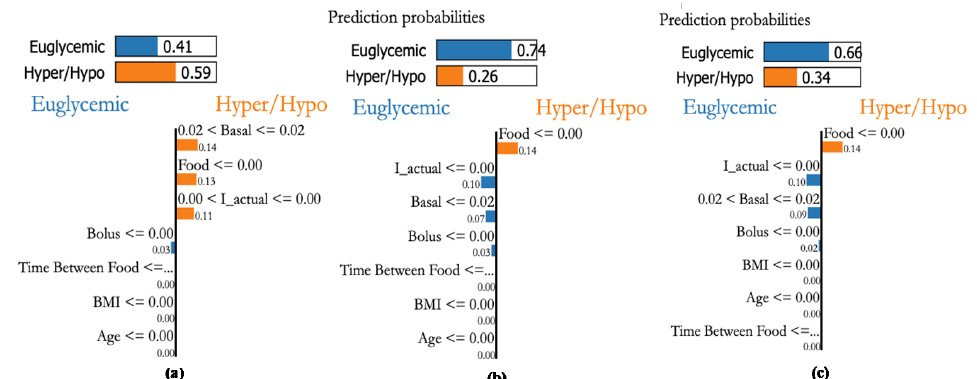
Figure 22. Explanations for three randomly selected samples of patient P1. ( a ): An actual sample in the hyperglycemic range detected with high probability through XAI as basal value of 0.02, ( b ): sample 2 that is in Euglycemic range being detected with high probability with Insulin actual values, ( c ): Sample in Euglycemic range detected with probability of 0.64 through basal and bolus